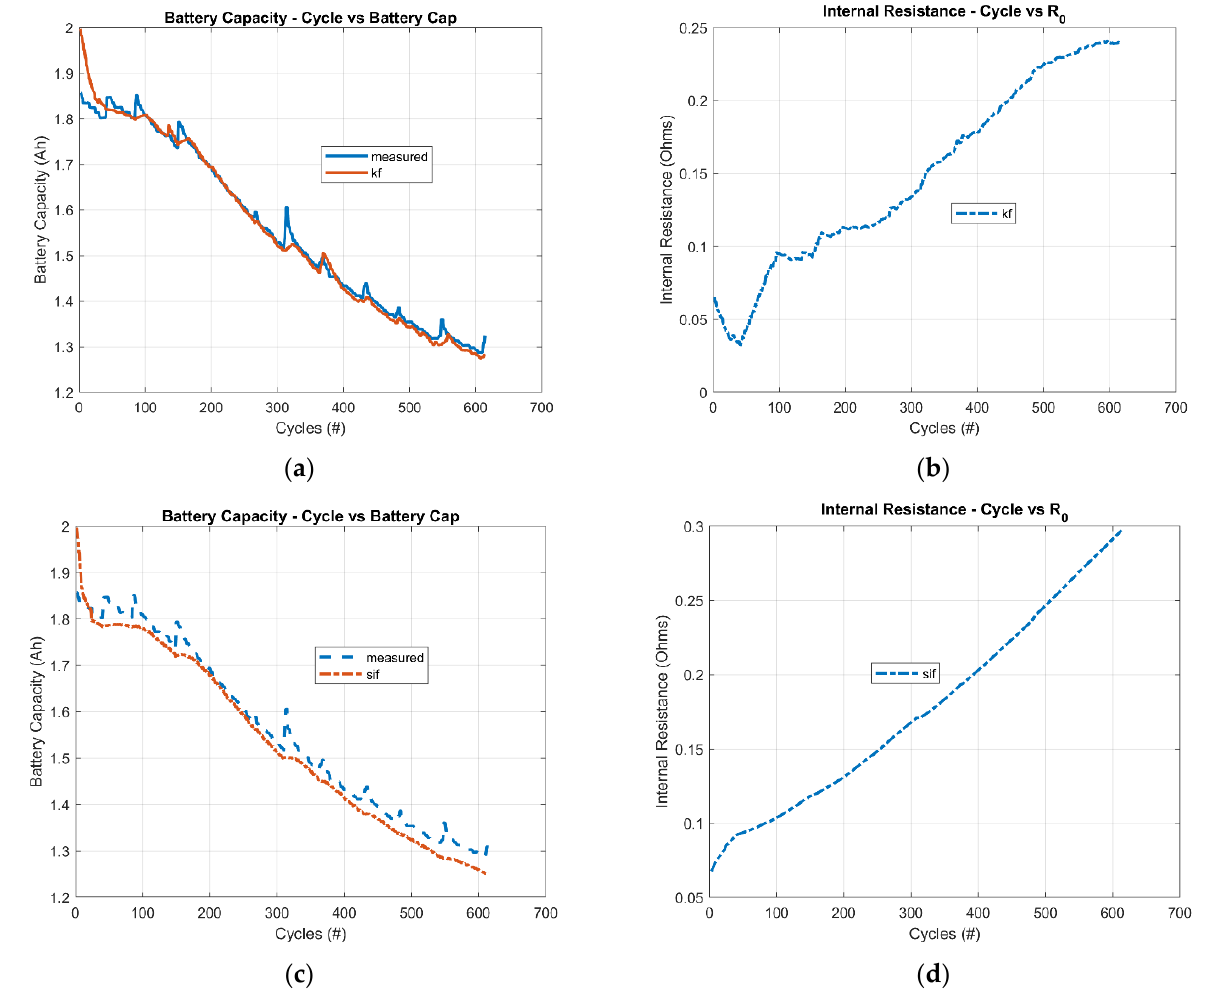
Figure 9. Dual Estimation: ( a ) Dual-KF Battery Capacity Estimation. ( b ) Dual-KF Internal Resistance Table 4. RMSE Results.